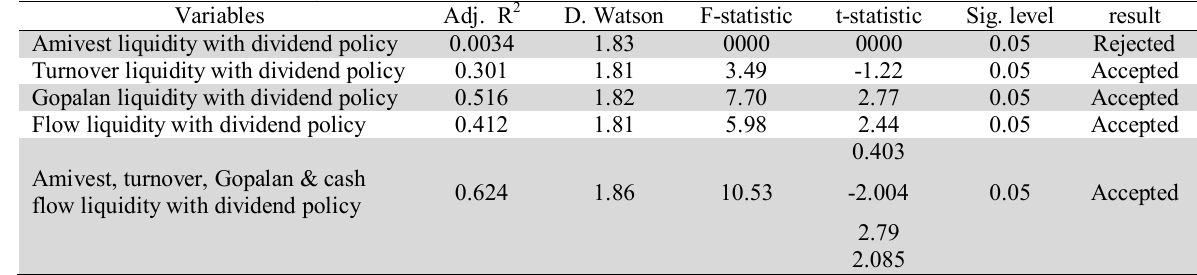
A summary of the finding of the study of the relationship between the variables of the